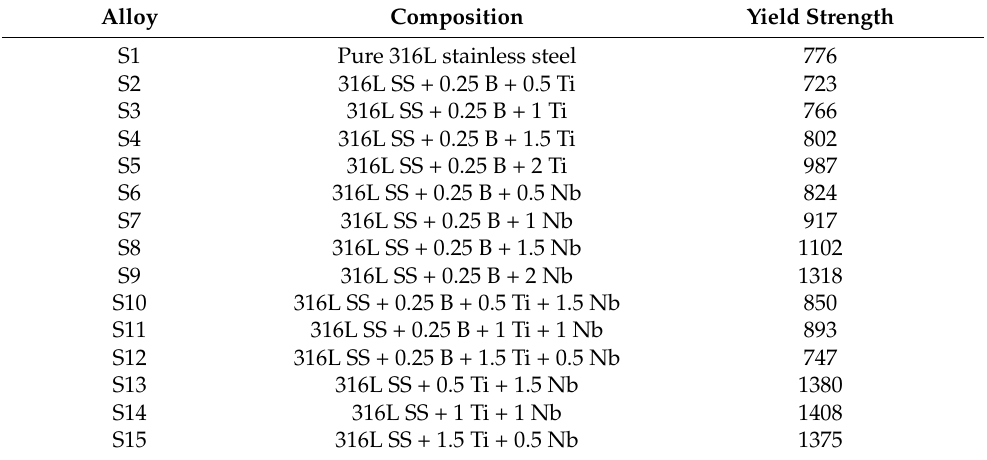
Table 6. Compressive yield strengths of all